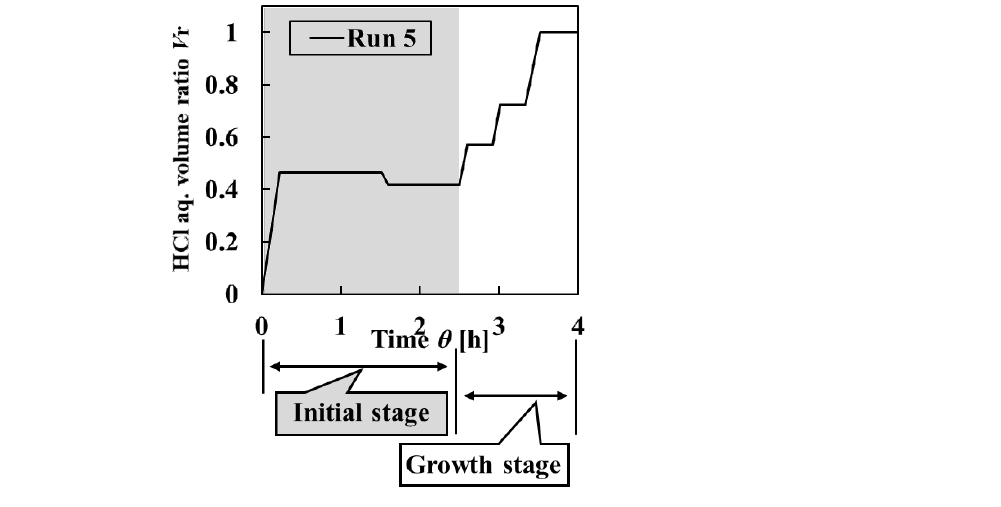
Figure 10. Change in HCl aq. volume ratio V r against the crystallization time in Run 5.